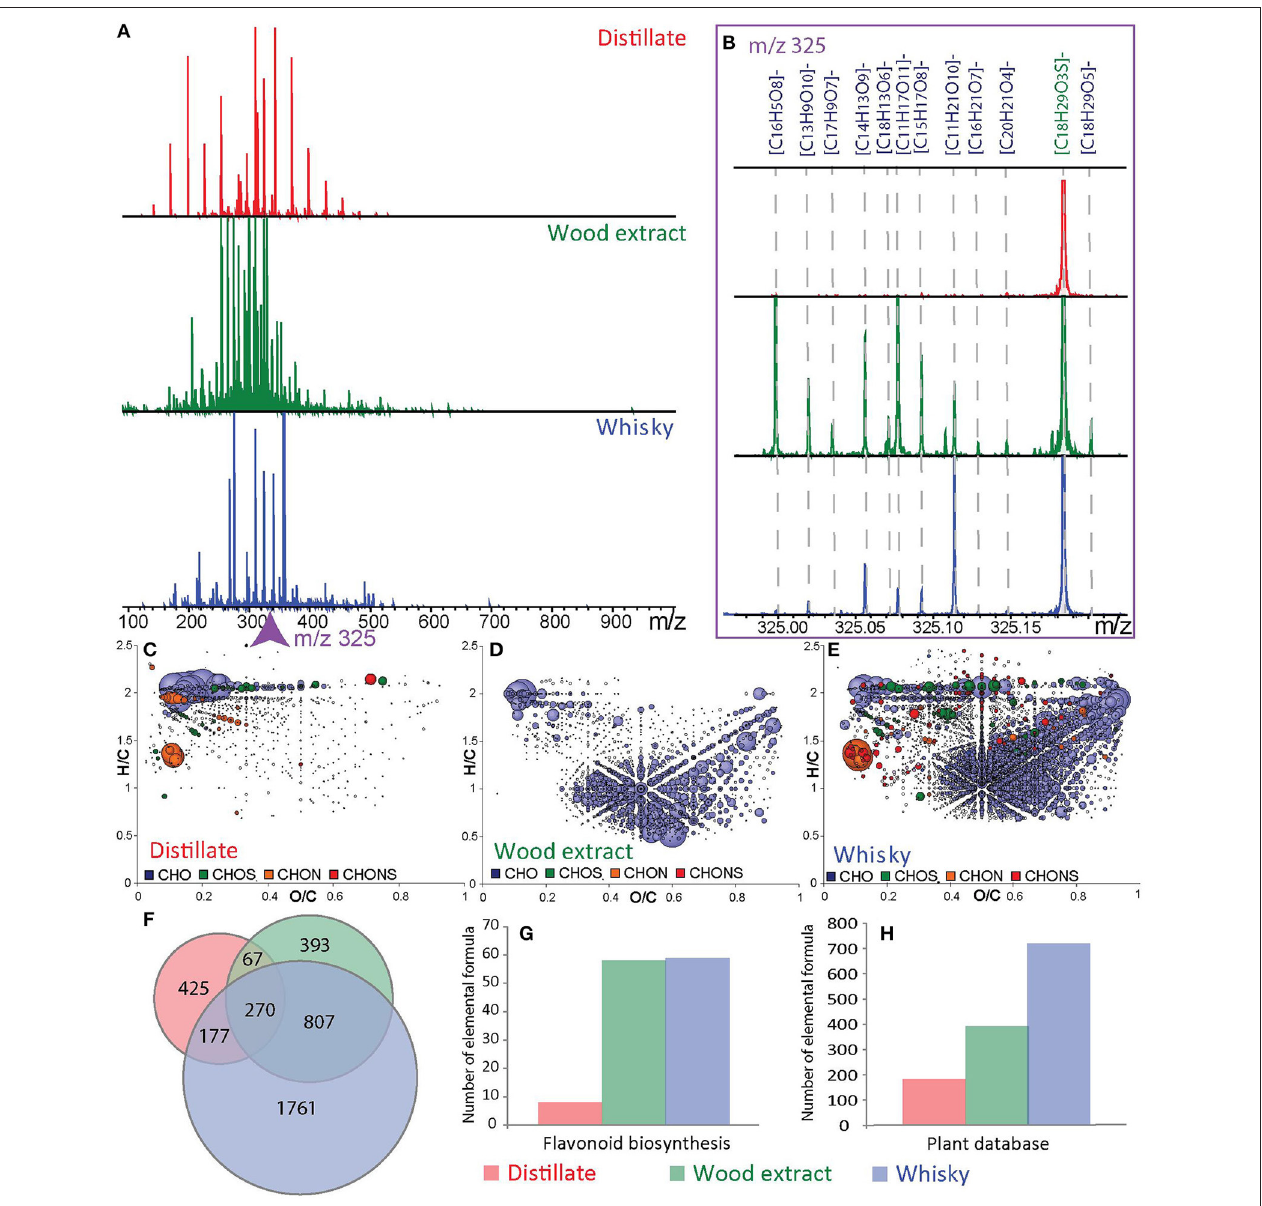
FIGURE 2 | ESI (-) FT-ICR-MS spectra from a distillate, wood extract and whisky sample (A) in the mass range from 100 to 1,000 Da. Enlargements of the nominal mass m/z 325 (B) with molecular formulas assignments. Van Krevelen diagram (H/C vs. O/C atomic ratio) of the distillate (C) , wood extract (D), and whisky (E) . The common and uncommon features from the distillate, wood extract and whisky are represented in a Venn diagram (F) . Histograms of annotated data in the flavonoid biosynthesis pathway (G) and in a home-build plant database (H) . Points in the van Krevelen diagrams are colored according to their elemental composition, CHO in blue, CHOS in green, CHON in orange, and CHONS in red, and scaled according to their relative peak intensities.